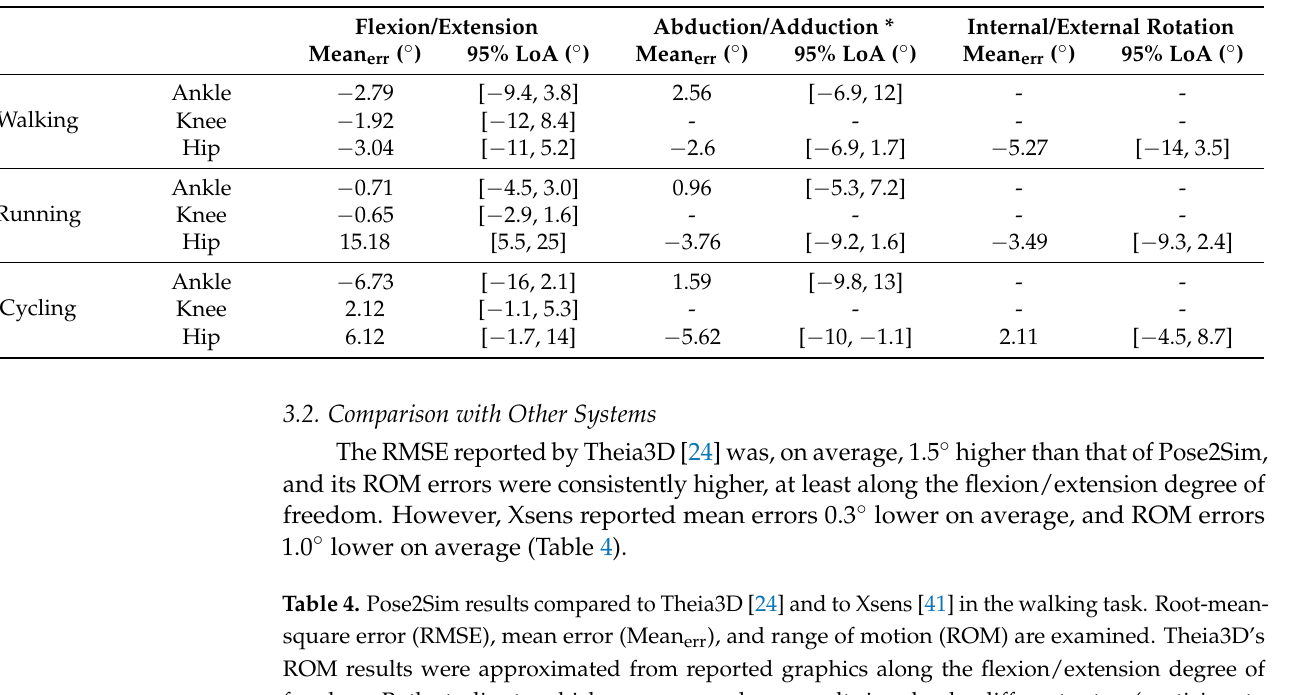
Table 3. Bland–Altman analysis results of 3D angle errors between Pose2Sim analysis and the refer- ence marker-based one. Mean errors (Mean err ) and 95% limits of agreement (LoA) are represented. * Although ankle subtalar angle combines abduction/adduction and internal/external rotation, it is hereafter reported in the abduction/adduction column.